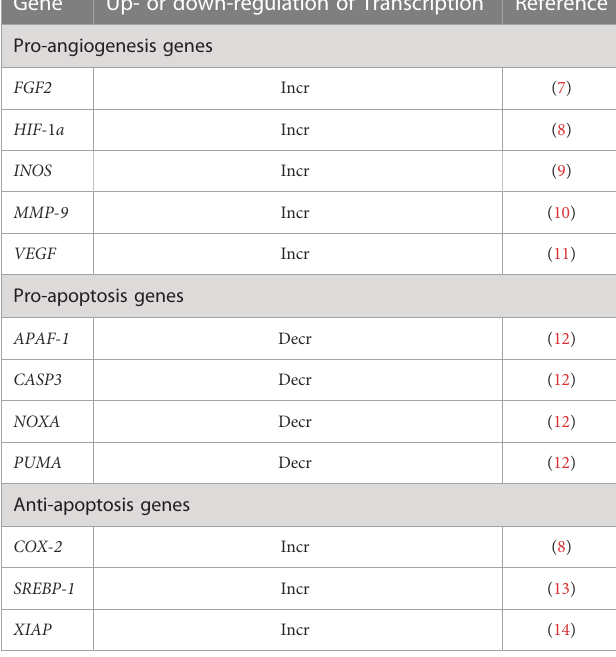
TABLE 1 Genes relevant to angiogenesis and to apoptosis whose expression is differentially regulated nongenomically by T4 at integrin a v b 3 on tumor